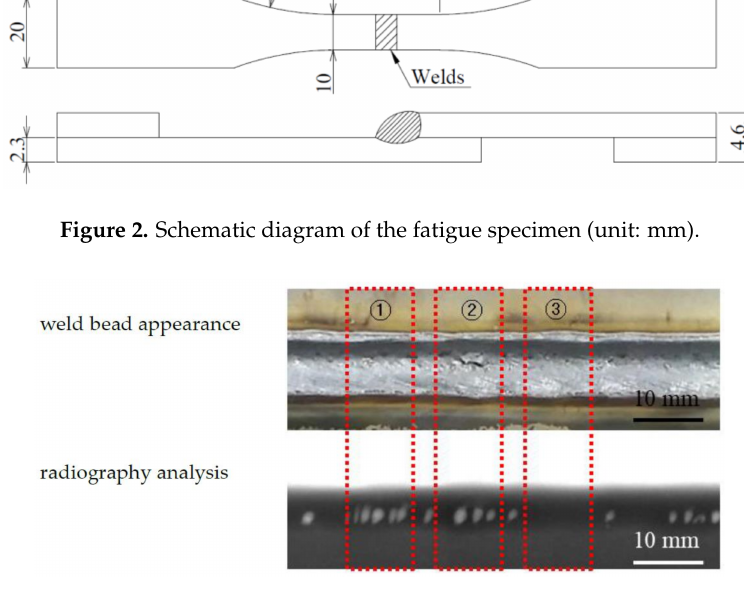
Figure 3. Weld bead appearance and radiography analysis.